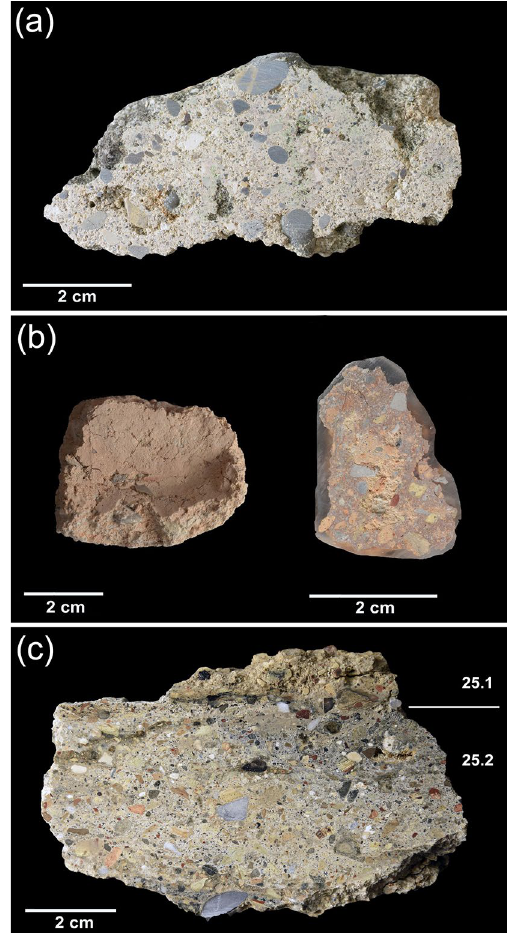
Figure 2. Cross sections of representative samples of the three groups of mortars. ( a ) WM_9 (Group 1); ( b ) PREF_13B (Group 2); ( c ) PREP_25 (Group